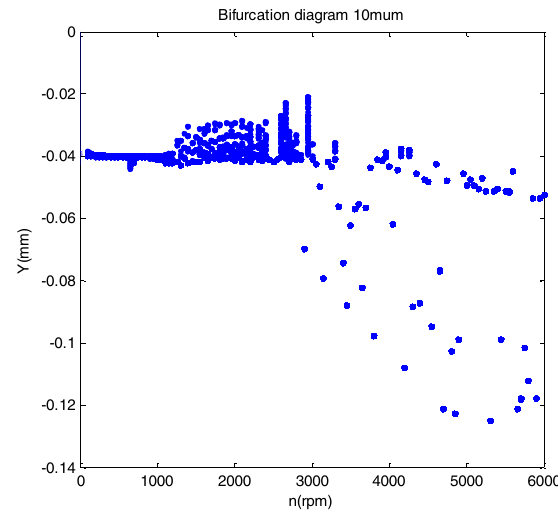
Fig. 4 Bifurcation diagram of the dynamic response: the displace- ment in y direction Y vs. rotational speed